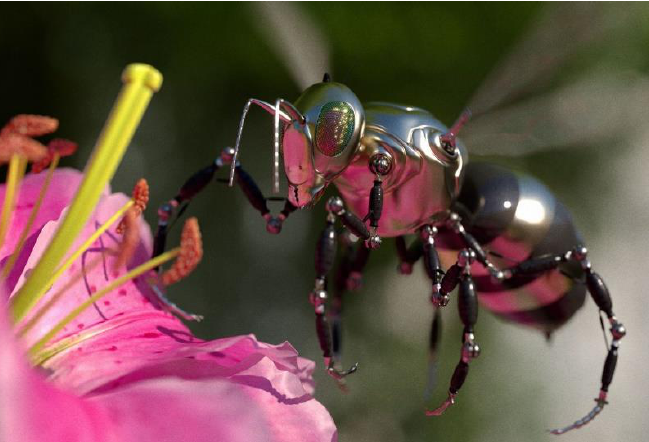
Figure 7. Robot bees developed by Arugga AI Farming Israel for cross-pollination.